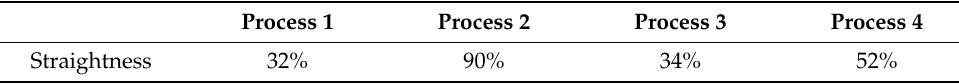
Table 2. Different types of tungsten wire straightness.